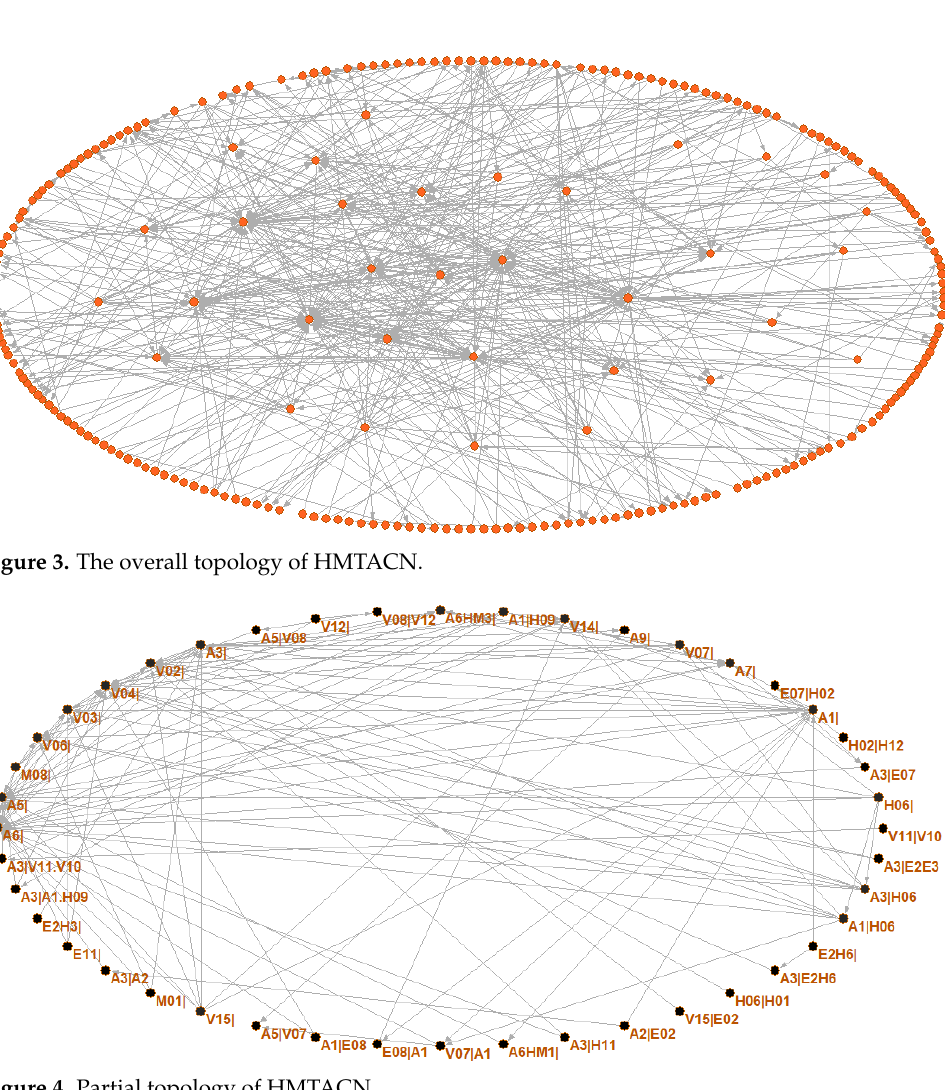
Figure 4. Partial topology of HMTACN.